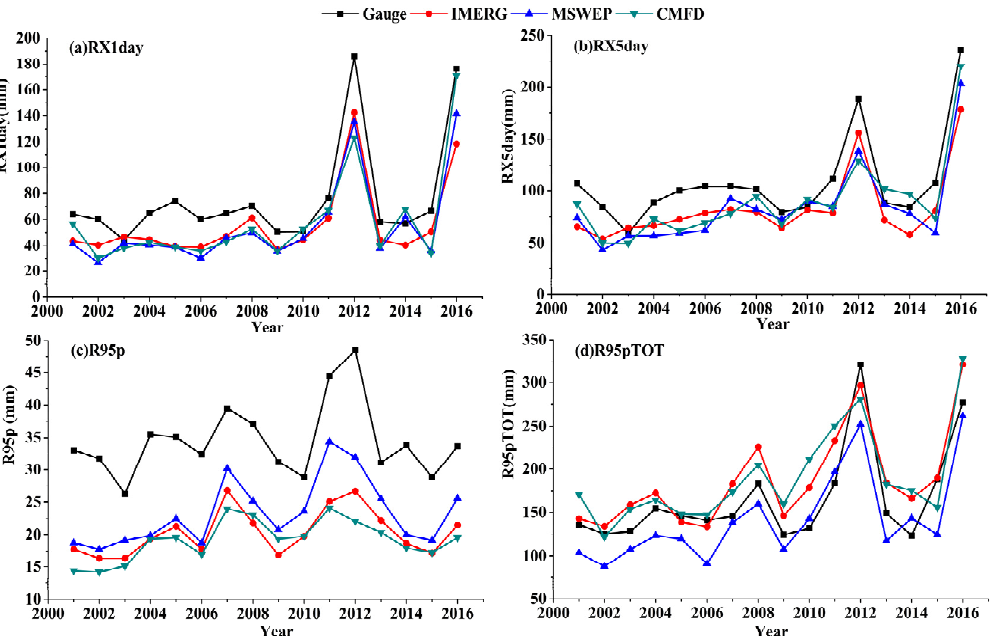
Figure 4. Extreme precipitation index values of the rainfall station data and satellite-derived precipitation data during 2001–2016: ( a ) RX1day, ( b ) RX5day, ( c ) R95p, and ( d ) R95pTOT.